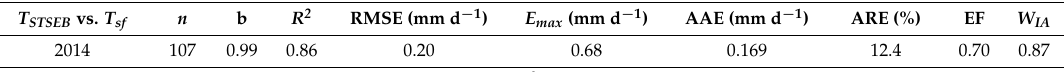
Figure 3. Crop transpiration modeled with STSEB ( T STSEB ) and measured with sap flow ( T sf ) in 2014. Table 5. Goodness of fit indicators relative to STSEB predicted transpiration values when compared with observed transpiration data derived from sap-flow